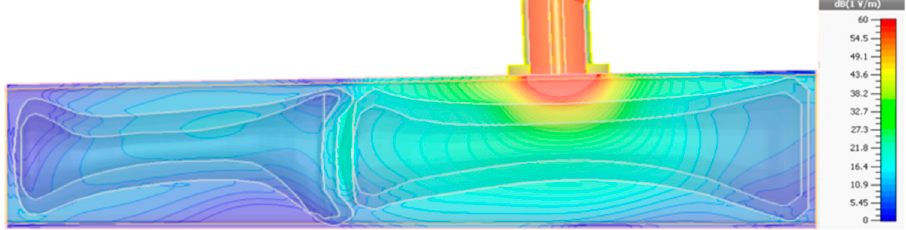
Figure 10. Cross-section of the finger model.